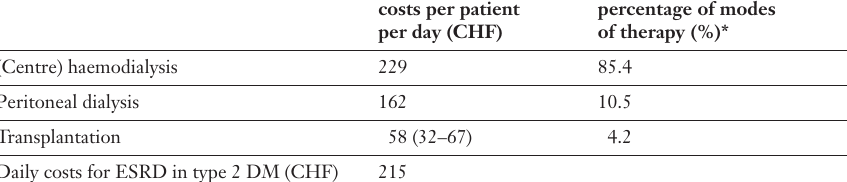
Daily costs of ESRD in type 2 DM per